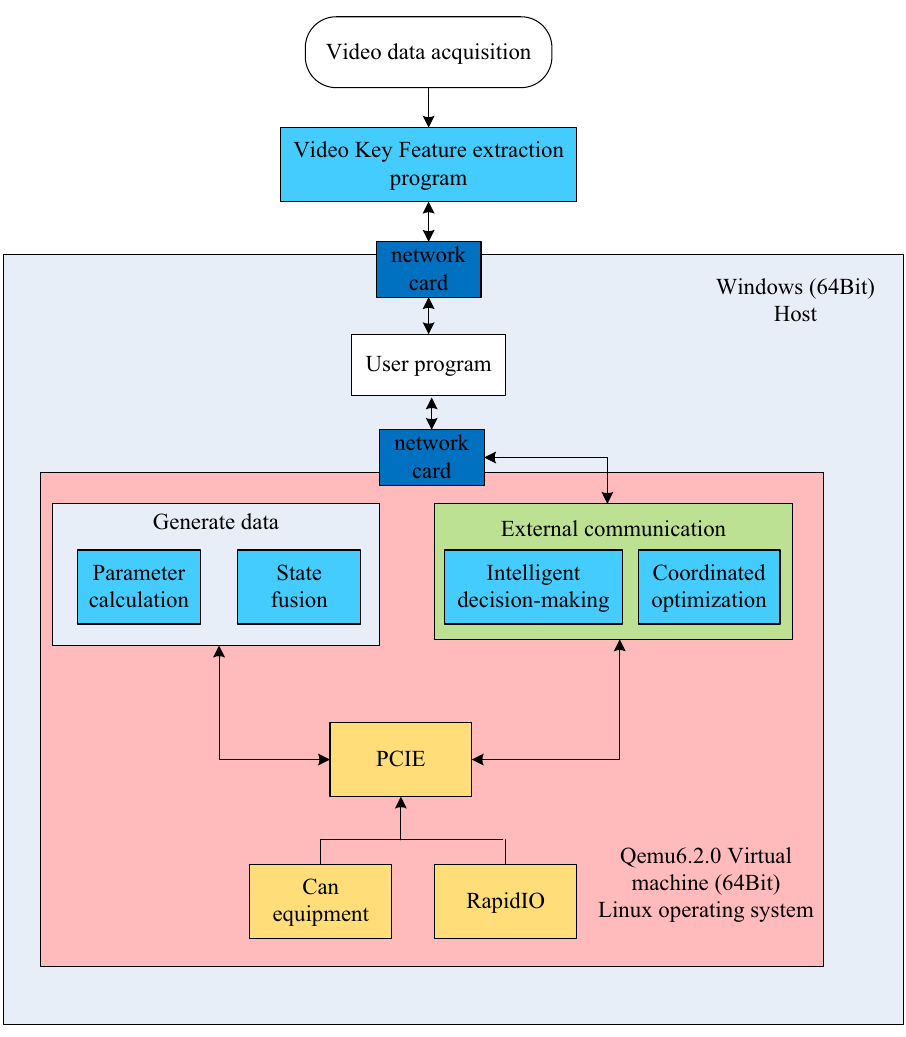
Figure 7. Developed traffic prediction and decision control model.